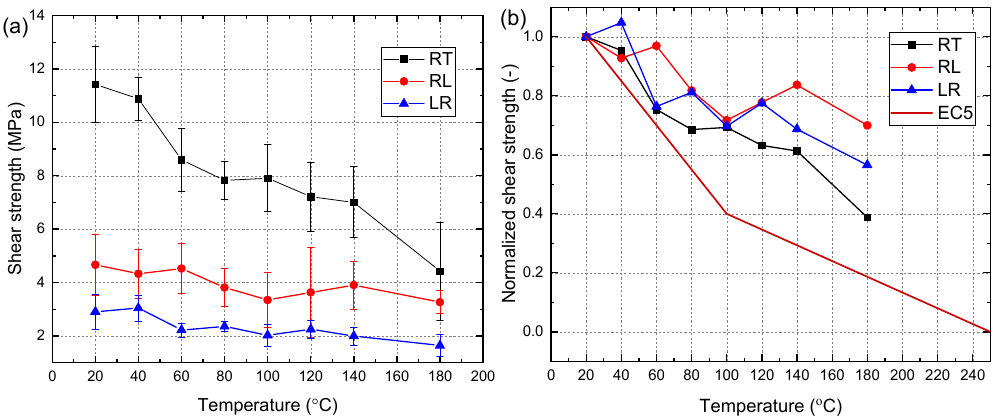
Figure 6. Shear strength of specimens: ( a ) Shear strength; ( b ) Normalized shear strength.